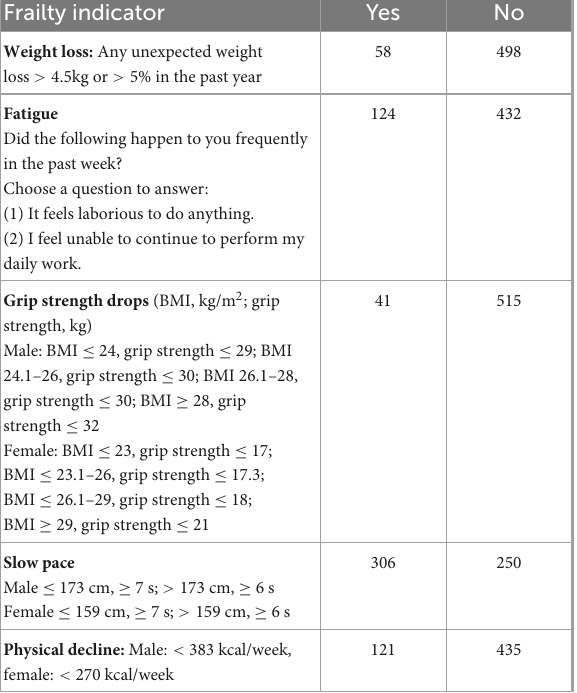
TABLE 2 The incidence of frailty in hospitalized patients with Schizophrenia ( n = 556). Frailty indicator